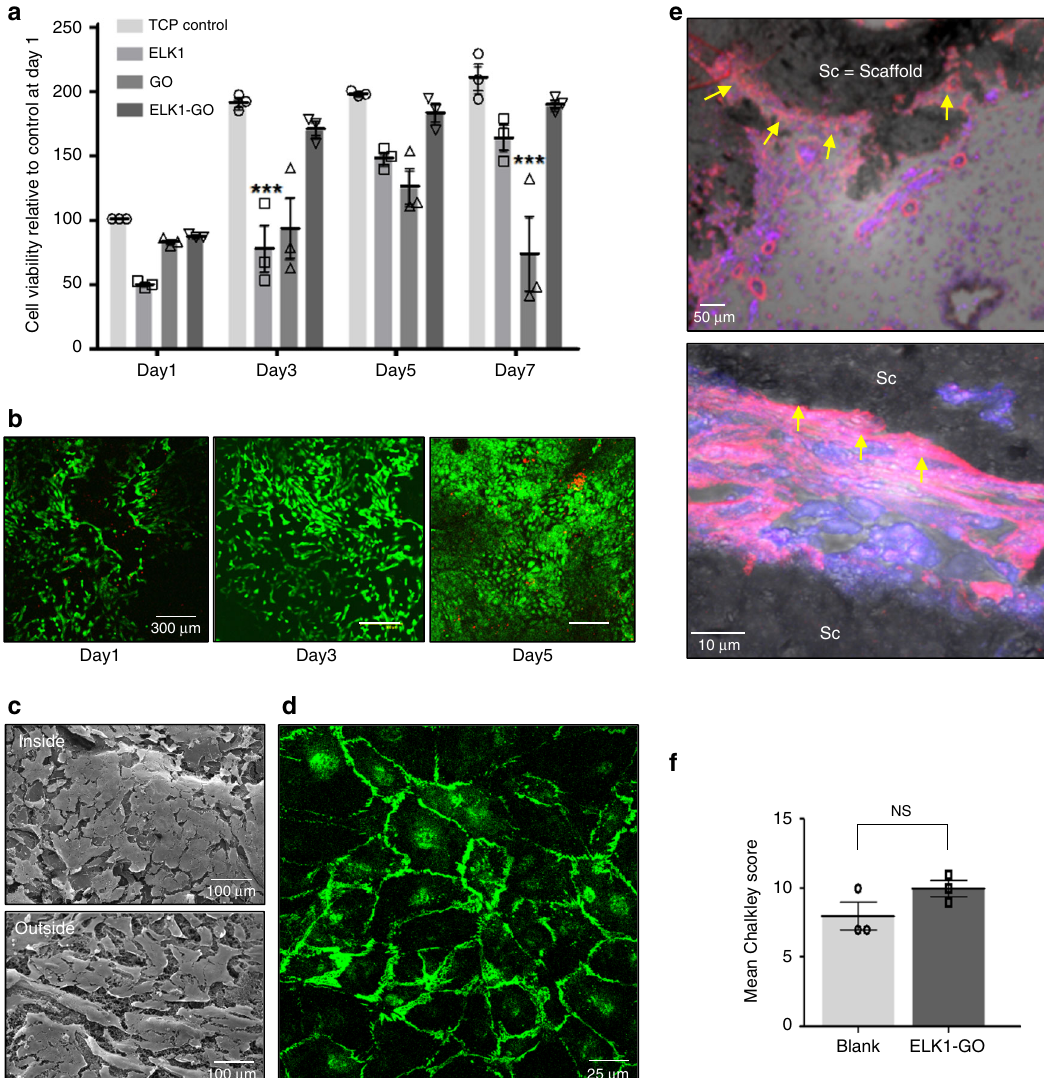
Fig. 5 In vitro biocompatibility and bioactivity of the ELK1 – GO membrane. a The applicability of the material was assessed by an MTS assay to test cell viability and proliferation of hUVECS on both sides of the ELK1 – GO membrane. The results revealed that cell viability and proliferation on ELK1 – GO materials are at least similar to those of cells growing on tissue culture plastic (TCP) for 7 days. Error bars represent ±s.d. for n = 3. * p < 0.05. Two-way ANOVA. b Live (green)/dead (red) assay con fi rmed the proliferation of hUVECs. c Scanning electron micrographs demonstrate the formation of an integral endothelial layer on both sides of the ELK1 – GO membrane. d VE – cadherin (CD144) was labeled to observe the organization of the intercellular junctions and revealed that cells exhibited strong intercellular junction staining, also suggesting the formation of an integral endothelial layer on the ELK1 – GO membrane. e Histological sections of the ELK1 – GO tube implants within a chick chorioallantoic membrane (CAM) model for 7 days highlighting alpha smooth muscle actin ( α -SMA, pink), and cell nuclei (blue). The results revealed endothelial cells forming capillary-like structures surrounding the ELK1 – GO tubes (yellow arrows). f Chalkley count analysis showing a slightly higher level of angiogenesis on tube-containing samples compared to control (blank model) samples. ±s.d. for n = 3. * p < 0.05. One-way ANOVA. NS no signi fi